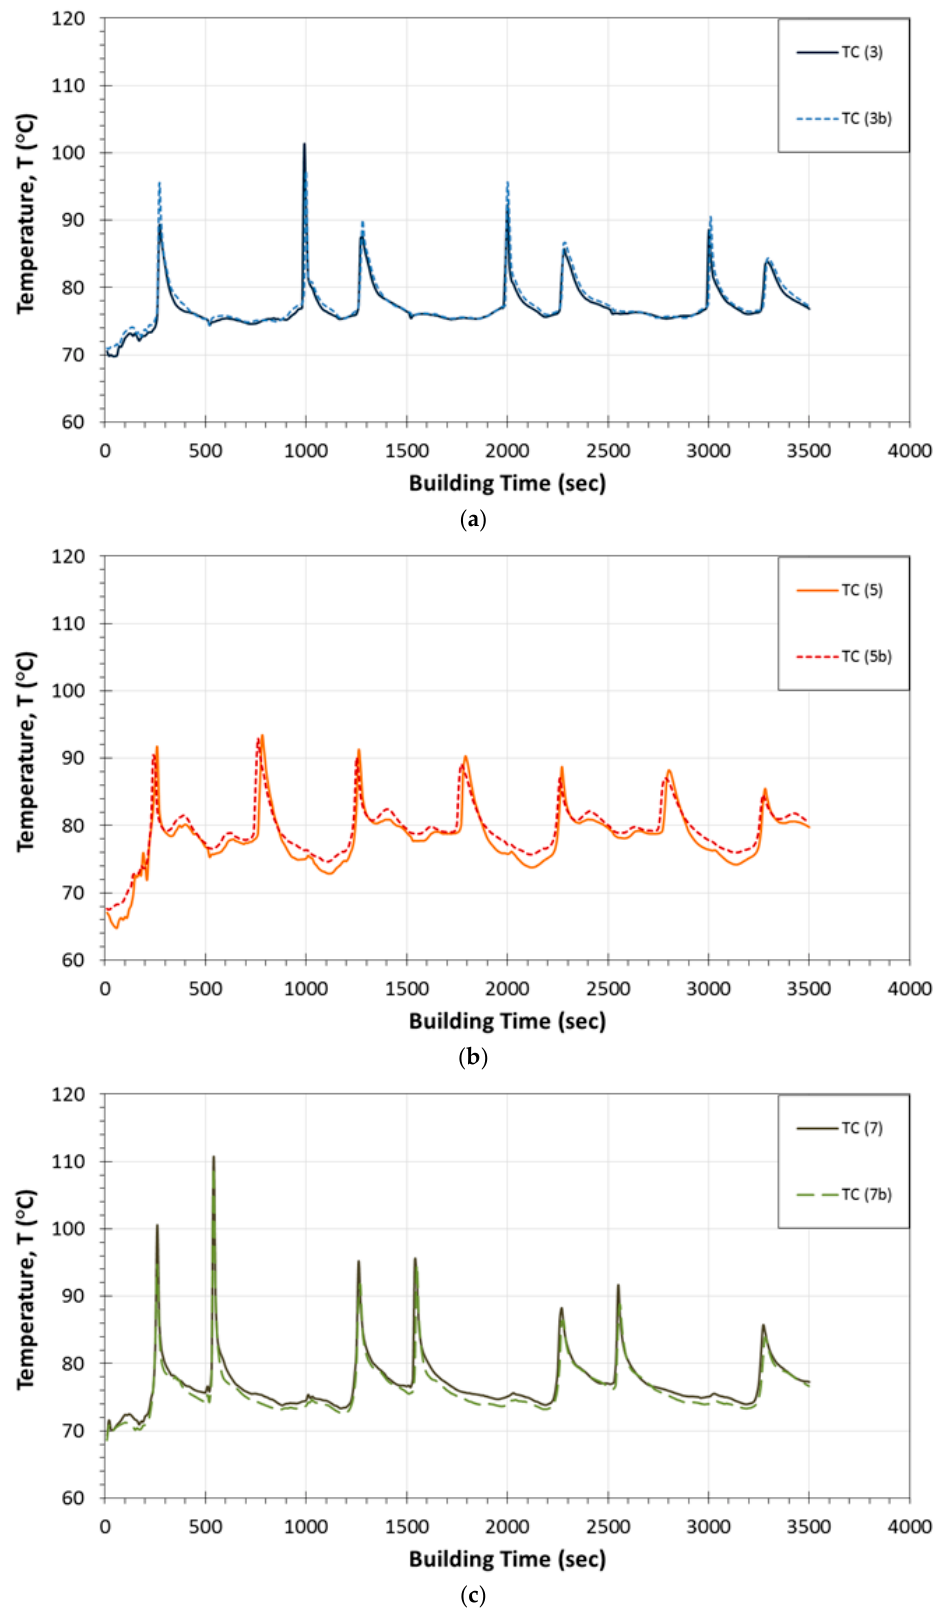
Figure 5. Comparison of temperature profiles measured during the printing process for embedding locations: ( a ) 3 and 3b; ( b ) 5 and 5b; ( c ) 7 and 7b.